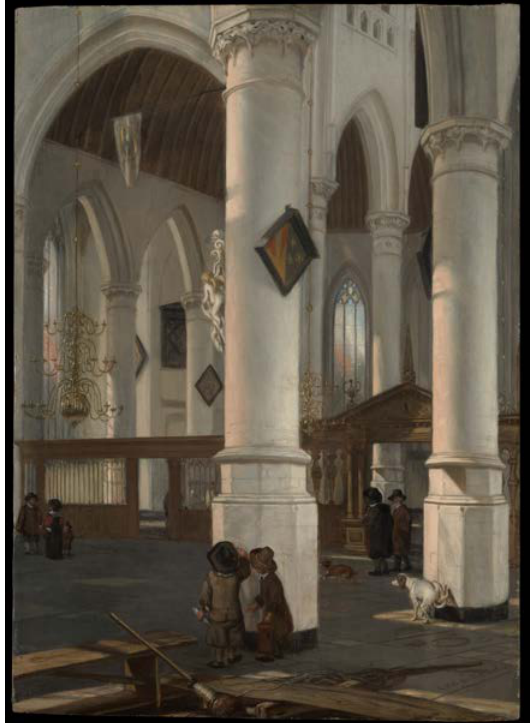
Figure 3 – Emmanuel de Witte, Interior of the Oude Kerk, Delft (ca. 1650). The Metropolitan Museum of Art, New York, CC0 1.0 Universal (CC0 1.0) - Public Domain